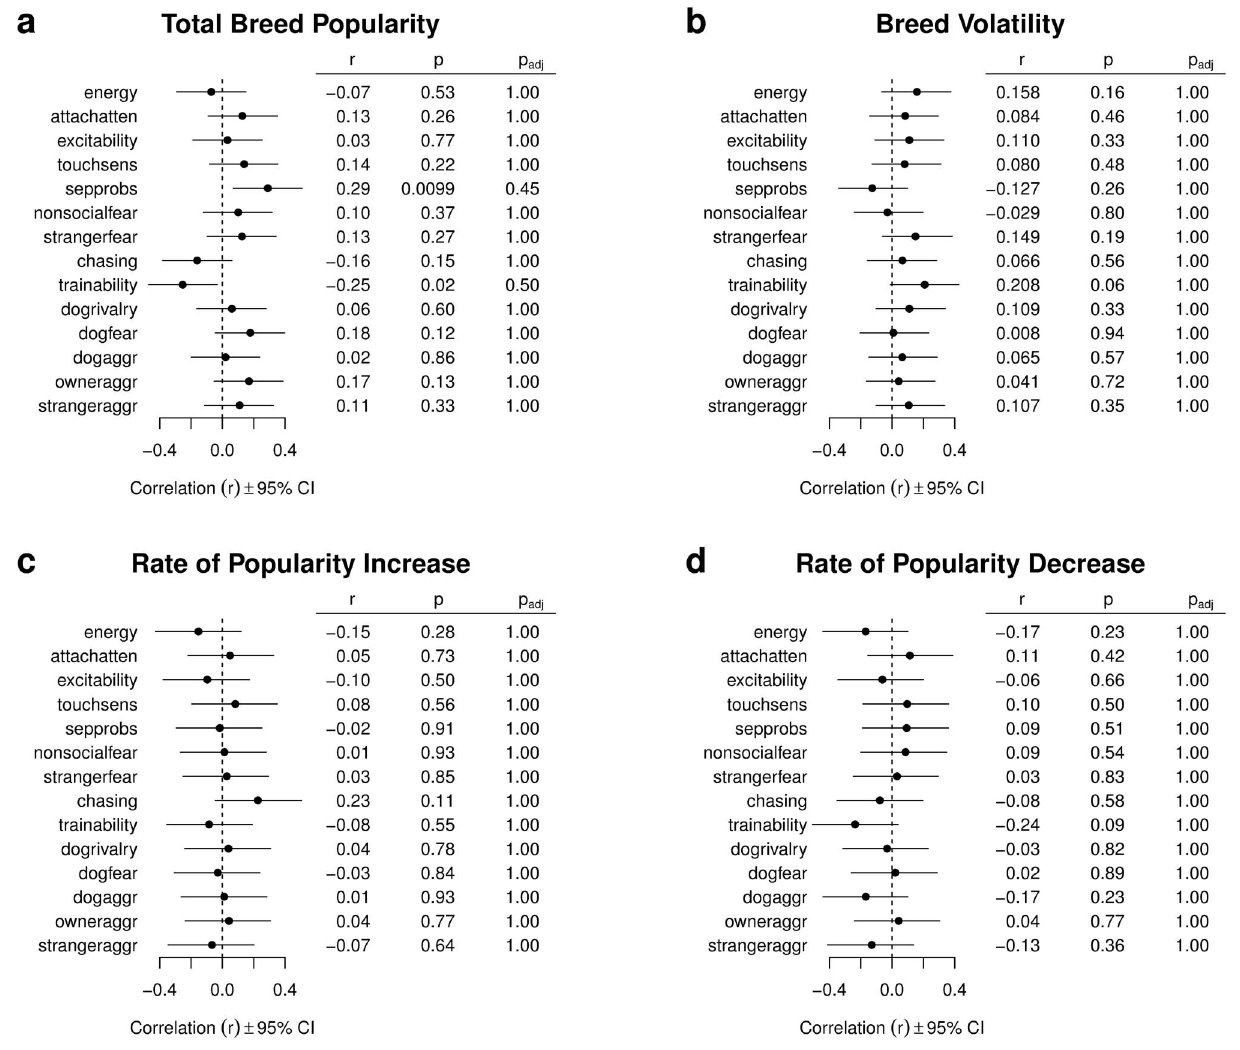
Figure 2. Correlations between measures of breed popularity and behavior variables from the C-BARQ questionnaire. Each panel displays Pearson’s correlations between one measure of breed popularity (total number of dogs, breed volatility, rates of increase and decrease around popularity peaks) and the 14 behavioral variables assessed by the C-BARQ questionnaire (Table 1). The correlations are displayed both graphically and numerically in the first table column. Confidence intervals (displayed graphically) and p values (reported in the second table column) are bootstrapped owing to non-normality; p values adjusted to control the false discovery rate [19] are reported in the third table column. The sample size for all correlations is N ~ 80